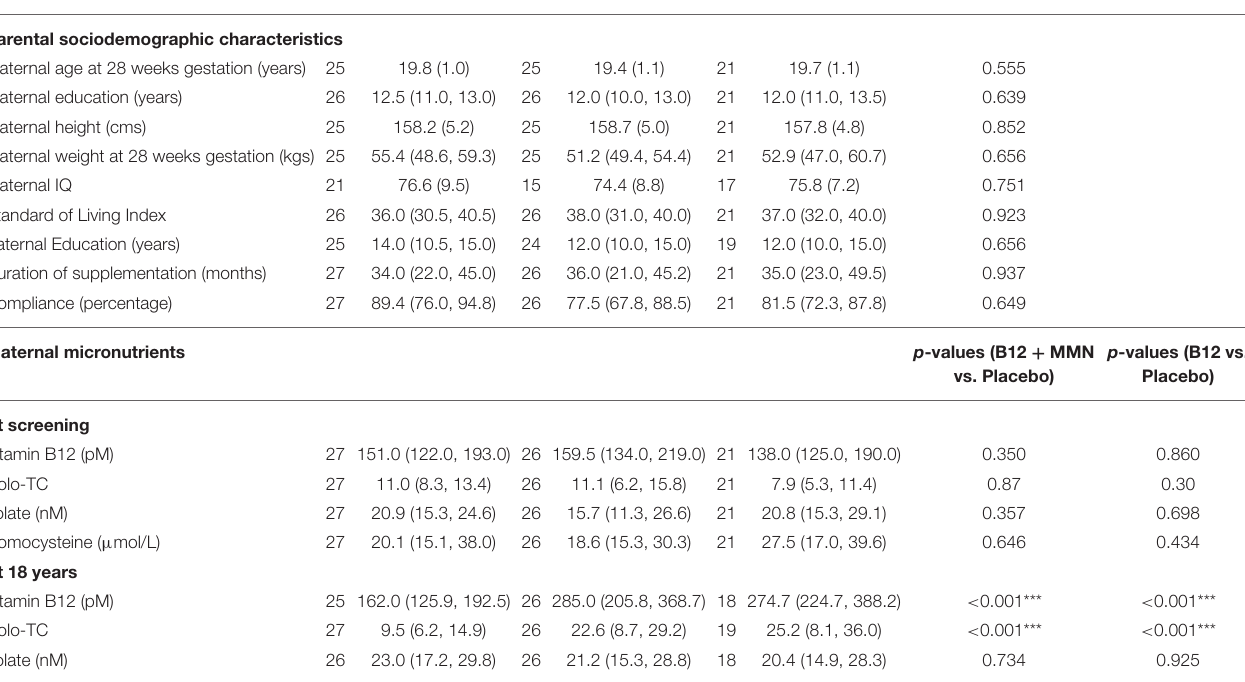
TABLE 1 | Maternal characteristics at baseline and in pregnancy, and child characteristics.